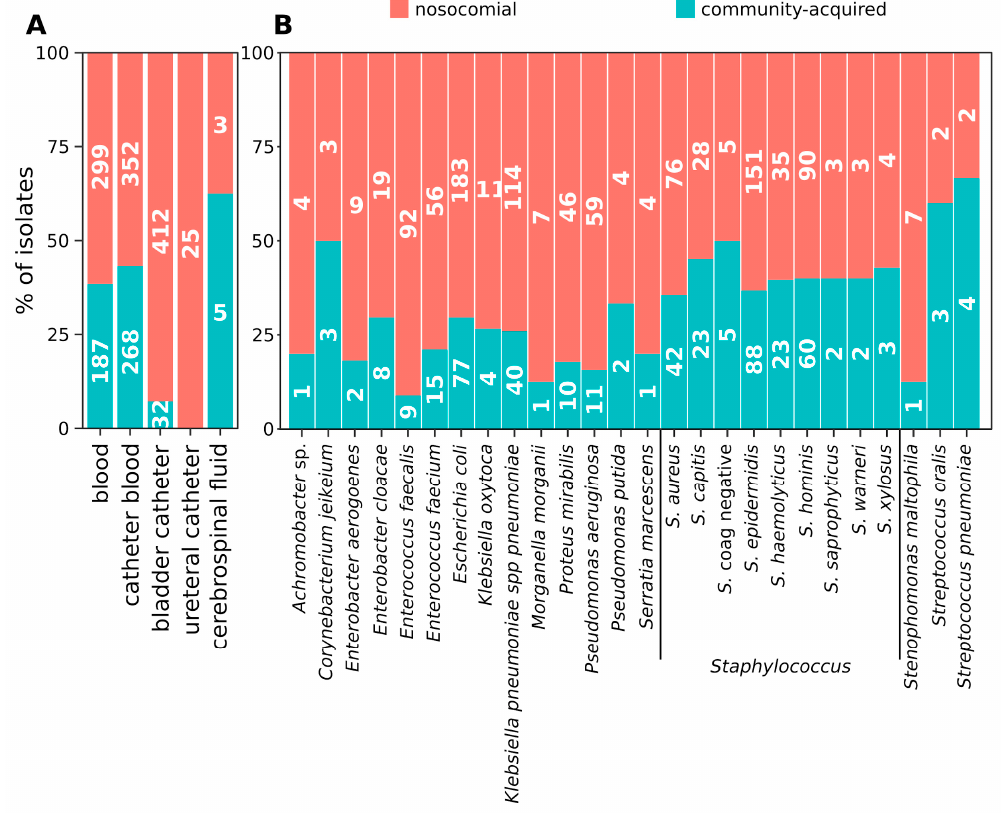
Figure 1. Distribution of nosocomial and community-acquired isolates according to the source of isolation and bacterial species. An isolate was considered “community-acquired” if the infection occurred within the first 48 h after the hospitalization of the patient, “nosocomial” if the infection occurred after 48 h. ( A ) distribution of nosocomial and community-acquired isolates according to the source of isolation. ( B ) distribution of nosocomial and community-acquired isolates according to the bacterial species. Only the bacterial species represented by at least five isolates are